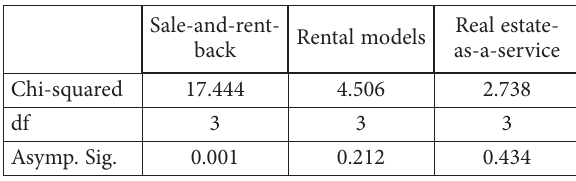
Figure 6. Acceptance to selected measures to pursue an ownership-reducing strategy Table 9. Kruskal–Wallis test statistic using structural change clusters as the grouping variable